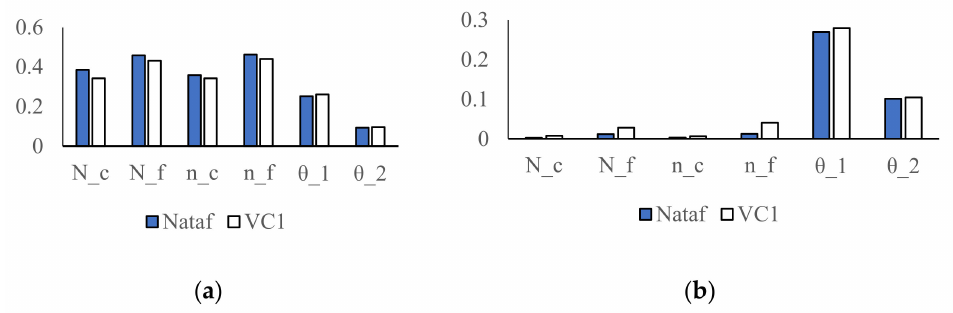
Figure 11. The values of Sobol’ indices; ( a ) S i , ( b ) S tot